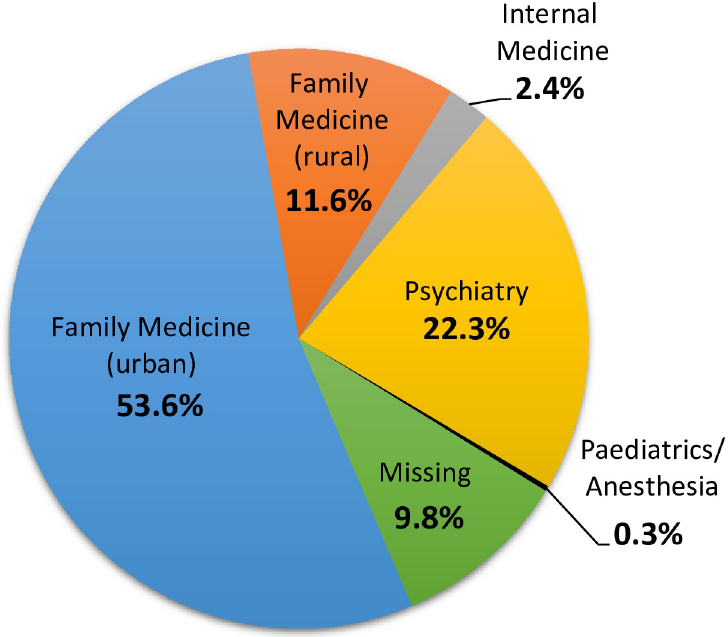
Fig 1. Physician specialties responsible for prescribing individuals’ first alcohol use disorder medication. Index dates 1996/97 to 2014/15.